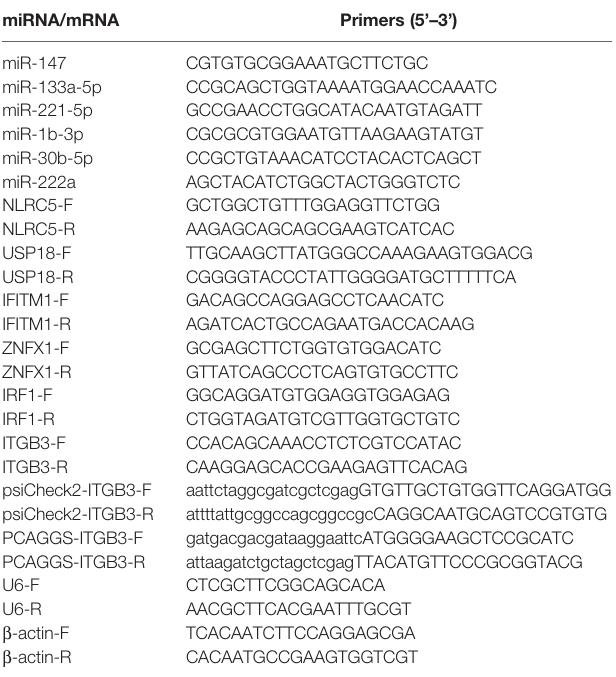
TABLE 1 | Primers for the RT-qPCR con fi rmation of the selected miRNAs and